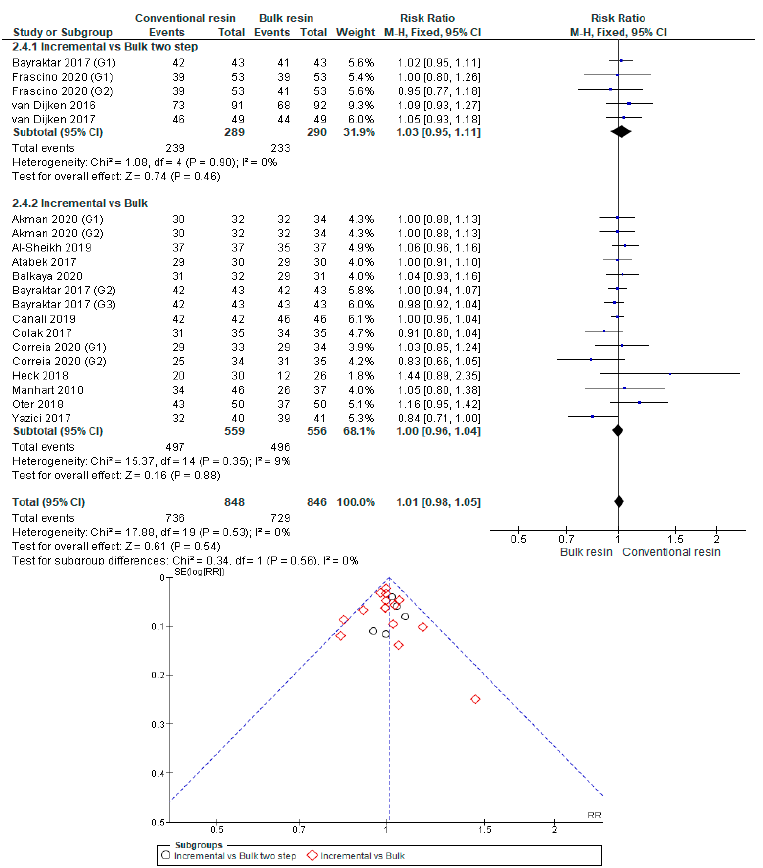
Figure A9. Absence of Discoloration or Marginal Staining: Conventional Resin versus Bulk Resin According to the Technique Used.